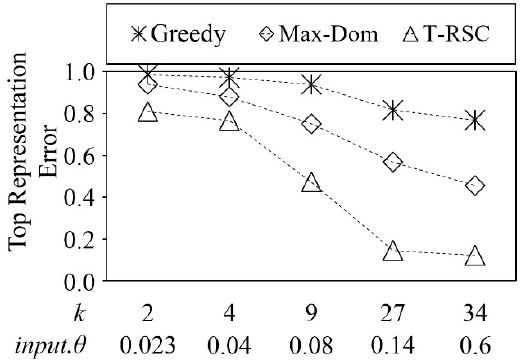
Figure 14. Comparison of top representation error on Anisotropic dataset.